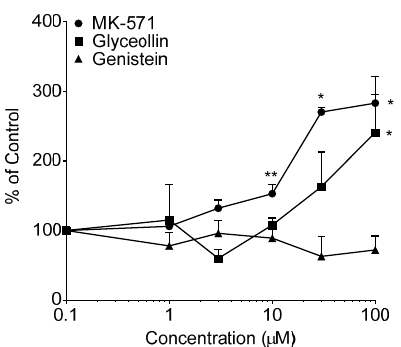
Figure 5. Calcein uptake in Caco-2 cells. Net fluorescence normalized to cell protein was measured following a 30-min incubation with 0.5 µ M CAM in the presence of varying concentrations of MK-571, glyceollin or genistein from 0 µ M (control, arbitrarily represented as 0.1 µ M on the log-scale) to 100 µ M. Results are expressed as the mean + SEM from two separate experiments (MK-571) or three separate experiments (glyceollin and genistein), with N = 4 for each concentration per experiment. * indicates significantly different from the respective compound control ( p < 0.05) from a one-way ANOVA followed by Tukey’s t -test; ** indicates significantly different from the control, 30 and 100 µ M conditions.